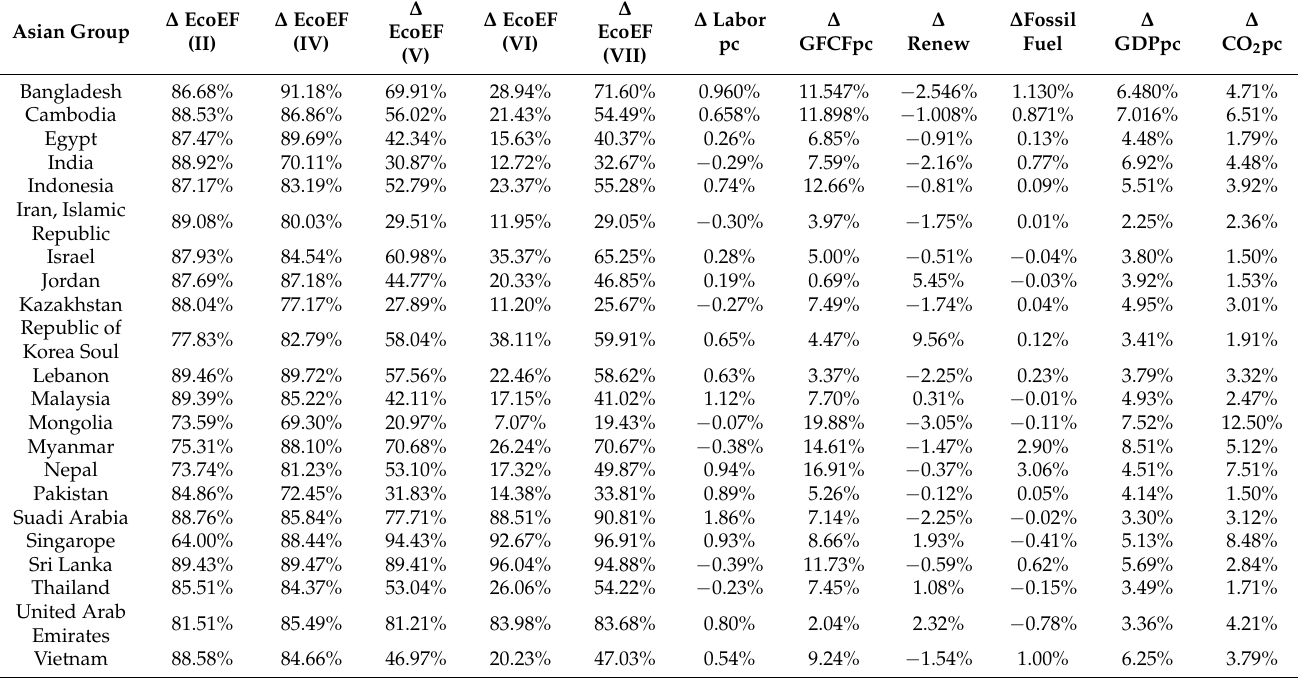
Table A1. Eco-Efficiency stochastic frontier analysis (SFA) scores for the 22 Asian economies and average growth rates by their